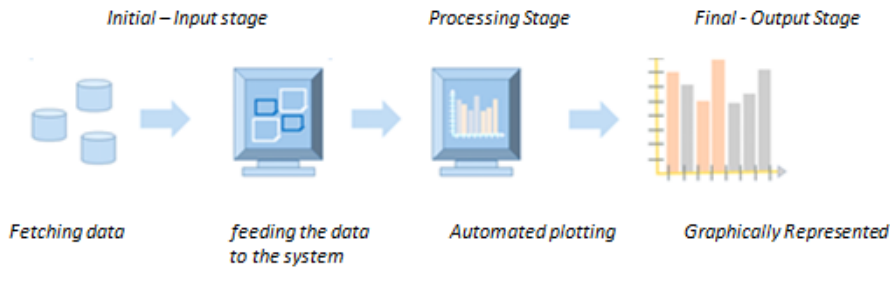
Fig. 2. Automated method of f Analyzing